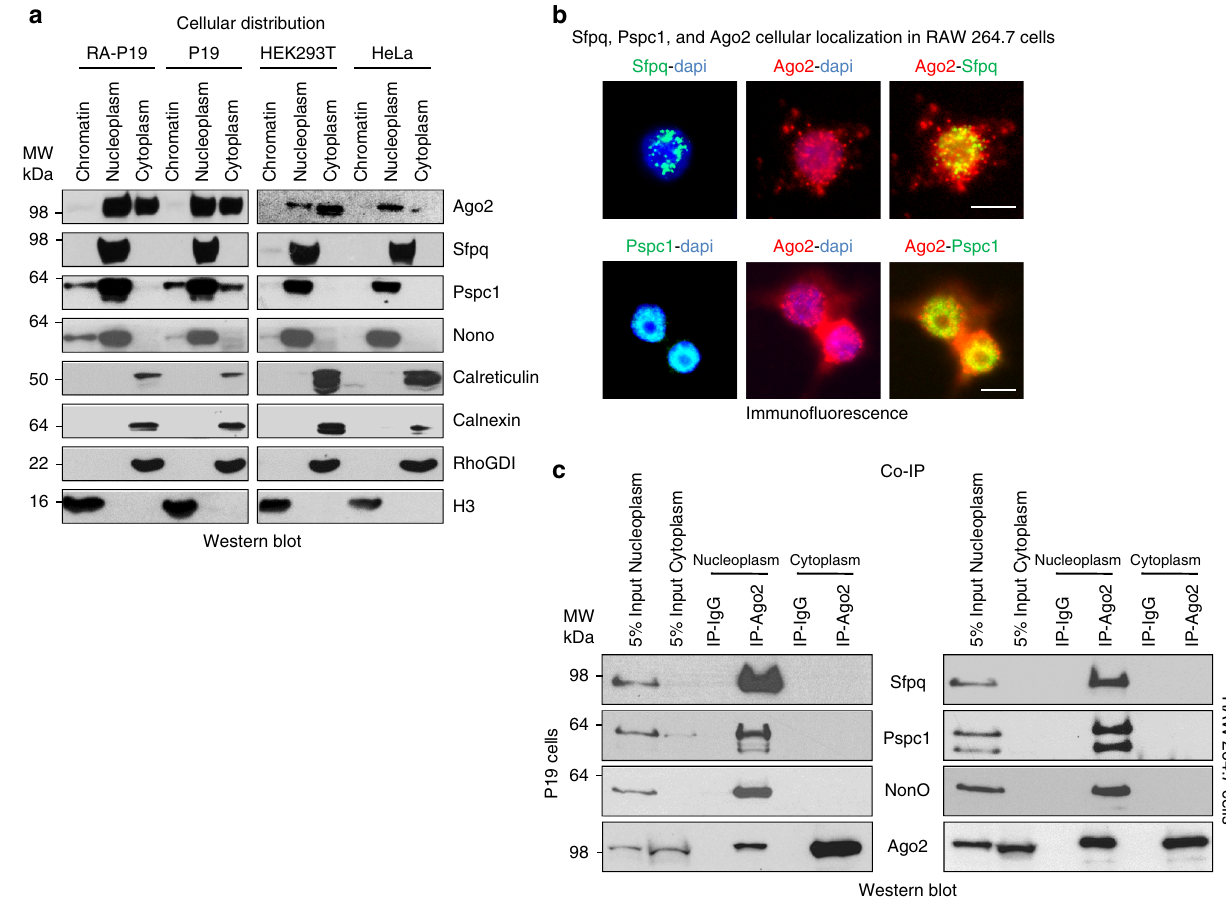
Fig. 3 Sfpq, Pspc1, and NonO interact with Ago2 in the nucleoplasm. a Immunoblot analysis of chromatin, nucleoplasm, or cytoplasm from HeLa, HEK293T, P19, or RA-treated P19 cells using antibodies directed to the indicated proteins. b Co-immuno fl uorescence analysis of RAW 264.7 cells stained with the indicated antibodies. Scale bar corresponds to 10 μ m. c Co-IP of endogenous Ago2 and the indicated proteins from nucleoplasmic or cytoplasmic extracts from RAW 264.7 or P19